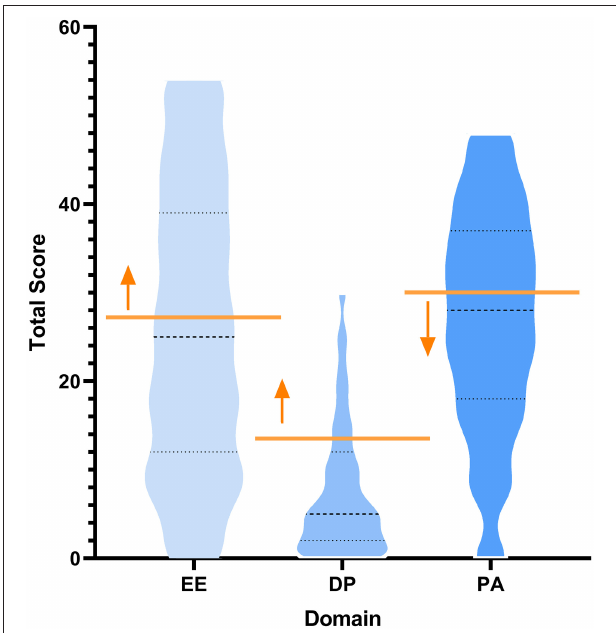
FIGURE 1 | Violin plot showing threshold and distribution for burnout. Yellow lines indicate high burnout threshold with respect to each domain. Arrows indicate all participants who met or exceeded the high threshold for burnout. EE, emotional exhaustion; DP, depersonalization; PA, personal achievement.